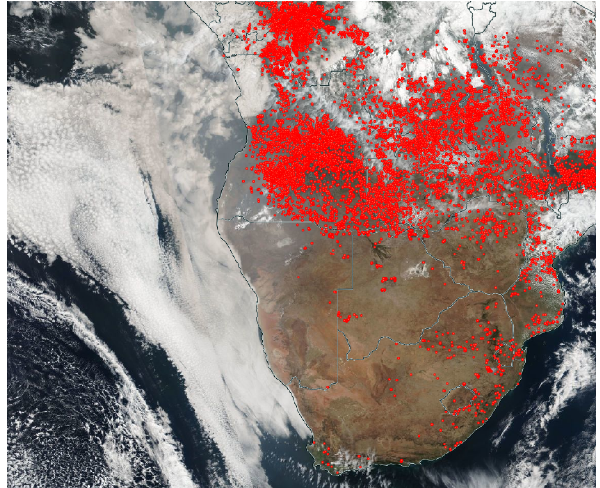
Figure 1. VIIRS true-colour image from 4 September 2017 show- ing smoke generated in central/southern Africa transported above marine stratocumulus clouds in the south-eastern Atlantic Ocean. Red dots indicate active fire detections. Region shown corre- sponds approximately to 36–2 ◦ S, 3 ◦ W–38 ◦ E. Image obtained from NASA Worldview, https://worldview.earthdata.nasa.gov (last access: 27 June 2019).